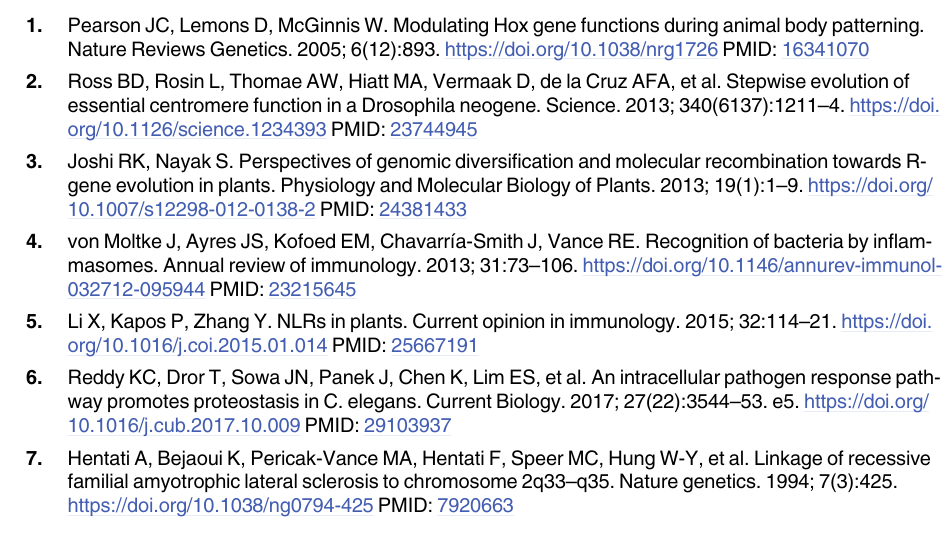
S7 Table. Detailed GSEA results. S8 Table. Human orthology